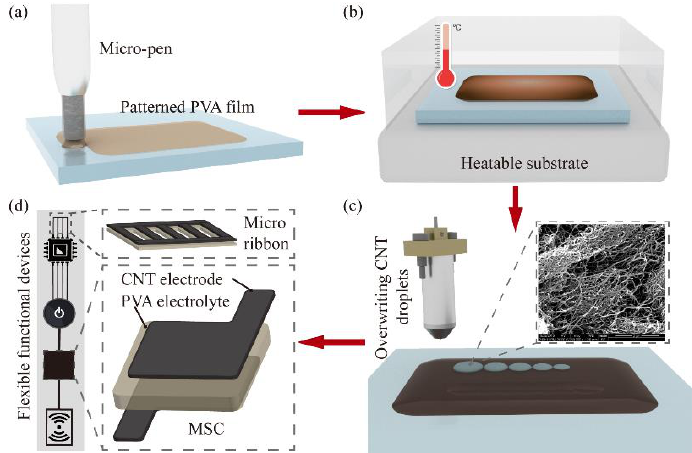
Figure 1. Schematic illustration of hybrid printing method for PVA-CNT flexible electronics fabri- cation. ( a ) Micro-pen writing was used to pattern the PVA film on the slide substrate. ( b ) Preprocessing of the written PVA film using heating in place. ( c ) CNT droplet DoD printing on the processed patterned PVA film. ( d ) Printed flexible PVA-CNT micro-ribbon circuit and the flexible patterned PVA-CNT film as an essential element of the